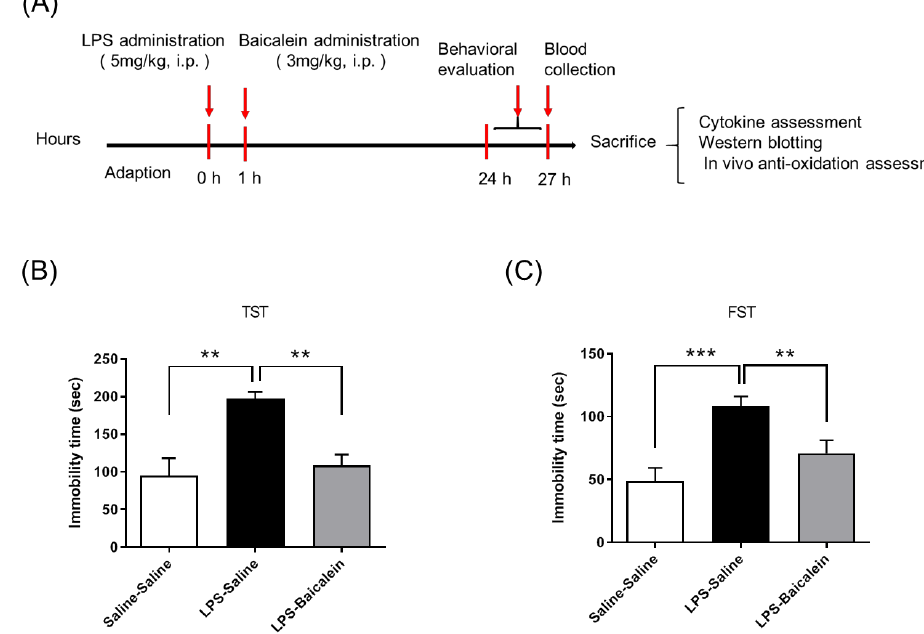
Figure 3. Study design and therapeutic effects of baicalein in mitigating LPS-induced depression-like behaviors. The time schedule of the study design ( A ). The control group was administrated with normal saline twice (at 0 h and 1 h). The LPS-treated group was administrated with saline instead of baicalein at 1 h. LPS-induced depression-like behavior was evaluated using the tail sus- pension test ( B ) and forced swimming test ( C ). Both tests show that immobility duration increased after administration of LPS (5 mg/kg i.p.). Treatment with baicalein (3 mg/kg i.p.) 1 h after LPS